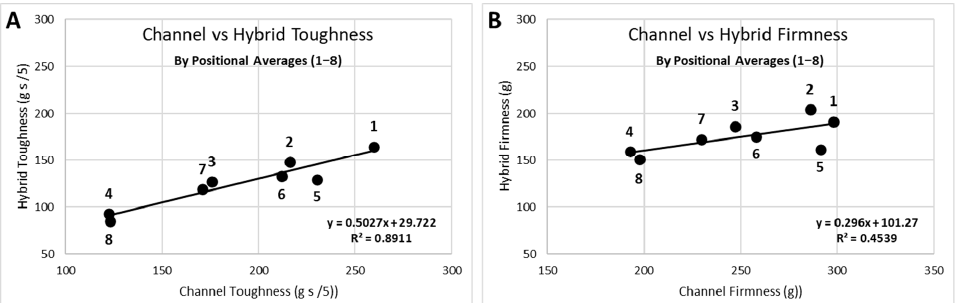
Figure 4. Data representation for parameters (channel vs hybrid) by positional averages for ( A ) toughness: Pearson’s correlation coefficient (r) = 0.94; and ( B ) firmness: correlation not significant.